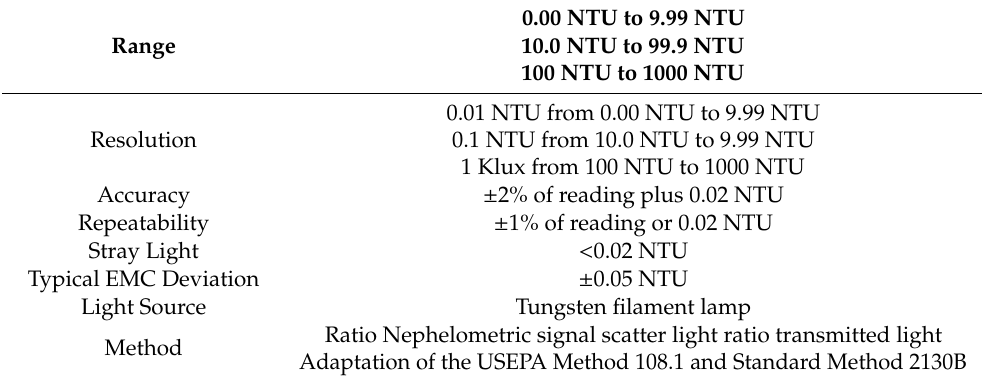
Table 9. Specification table for portable turbidity meter HI98703. NTU: Nephelometric Turbidity